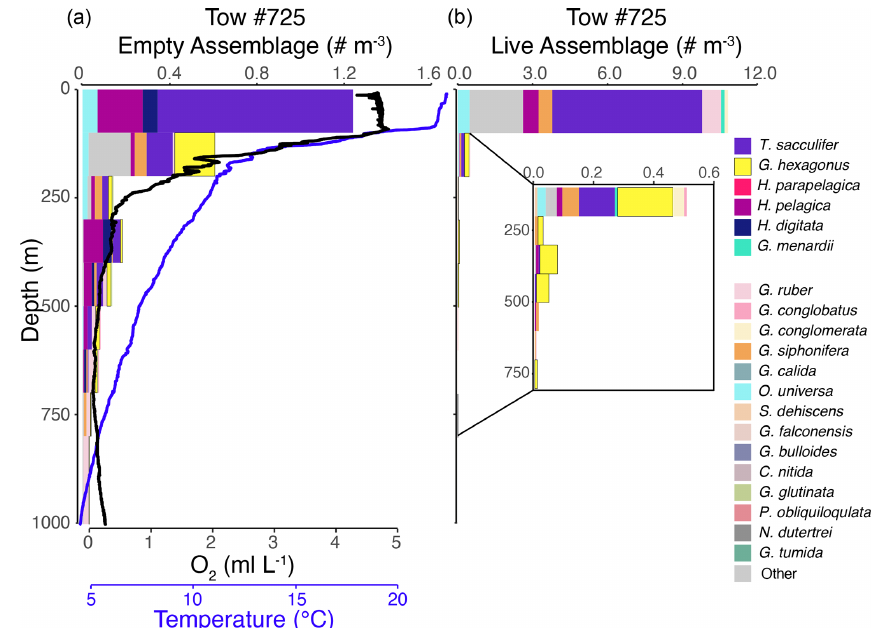
Figure 4. Vertical profiles of the empty assemblage, dissolved oxygen, and temperature (a) and live foraminiferal assemblage (b) from tow no. 725 (0–1000m). Each color represents a different species (see legend). Abundance axes vary, with the inset showing an enlargement of abundance data in that part of the water